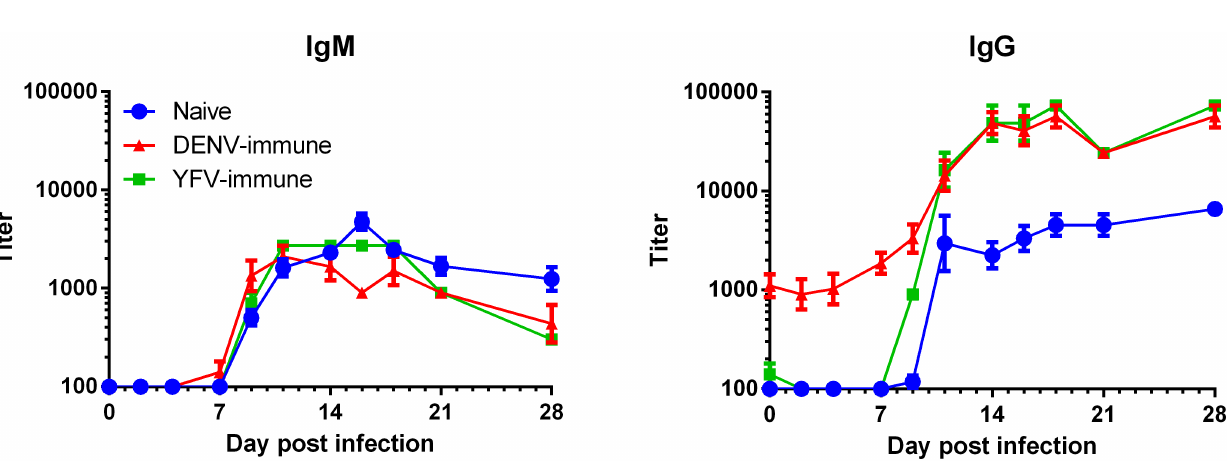
Fig 3. ZIKV IgM and IgG kinetics. Anti-ZIKV IgM and IgG kinetics were determinedby ZIKV-capture ELISA for each of the exposuregroups. The flavivirus na ï vegroup has a characteristic primary flavivirus antibody responsewith detectablelevels of ZIKV-reactive IgM precedingIgG, and both isotypes plateauingat a similar level. By contrast the DENV- and YFV-immune groups demonstrate characteristic secondaryflavivirus IgM and IgG kinetics with IgM followingsimilar kinetics to a primary infection and IgG kinetics reaching a substantially higherpeak titer than seen in primary ZIKV infection. Notably, the DENV-immune animalshad substantiallevels of ZIKV-reactive IgG on day 0, whereasYFV-immune animalshad much less. Means with SEM are displayed.